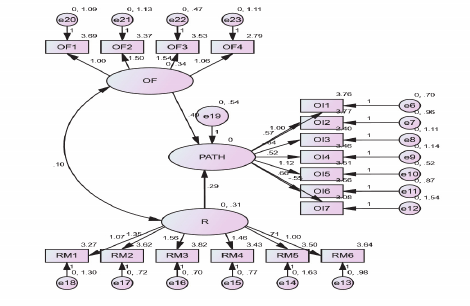
Fig. 5. Structural model between research mobilisation, organizational factors and pathway for entrepreneurs